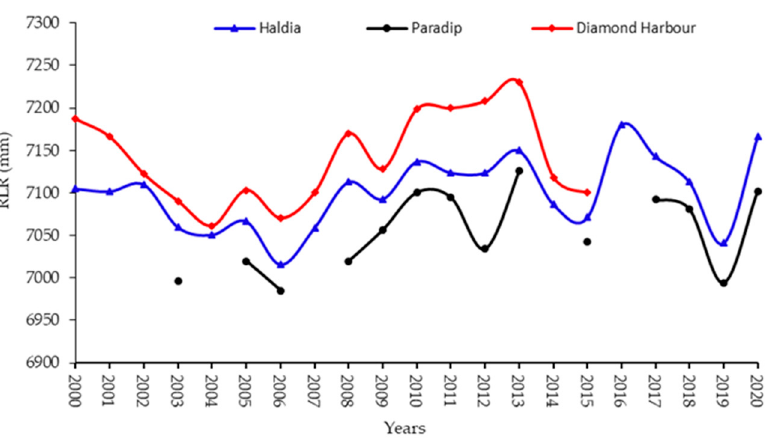
Figure 2. Temporal variations in yearly sea level at the Haldia, Paradip, and Diamond Harbour RLR gauge stations on the Bay of Bengal nearby the Subarnarekha river estuary (https://www.psmsl.org/data/obtaining/rlr.diagrams/1270.php (accessed on 7 May 2022)).